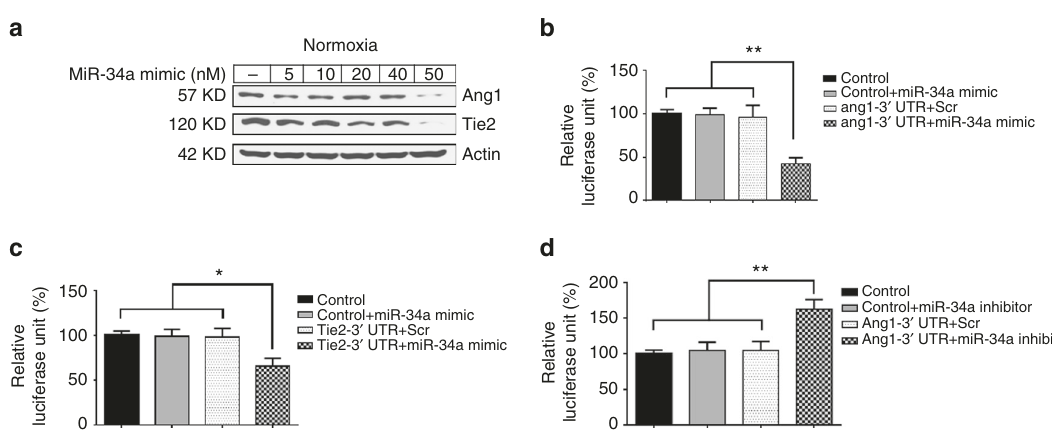
Fig. 3 miR-34a speci fi cally controls Ang1-Tie2 expression in lung epithelial cells. a MLE12 cells were transfected with different concentrations of miR-34a mimic in RA and western blots for Ang1 and Tie2 expression were performed. b The wild-type Ang1 3 ′ UTR reporter vector was co-transfected into the MLE12 cells with either the N.C. mimic or miR-34a mimic c The WT Tie2 3 ′ UTR reporter vector was co-transfected into the MLE12 cells with either the N. C. mimic or miR-34-a mimic. d The wild-type Ang1 3 ′ UTR reporter vector was co-transfected into the MLE12 cells with either the scrambled or miR-34a inhibitor. Ang1: Angiopoietin 1; WT: Wild-type; RA: room air; N.C.: Negative control. Values are means + SEM of a minimum of four observations. *P < 0.05, **P < 0.01, 2-way ANOVA, Tukey ’